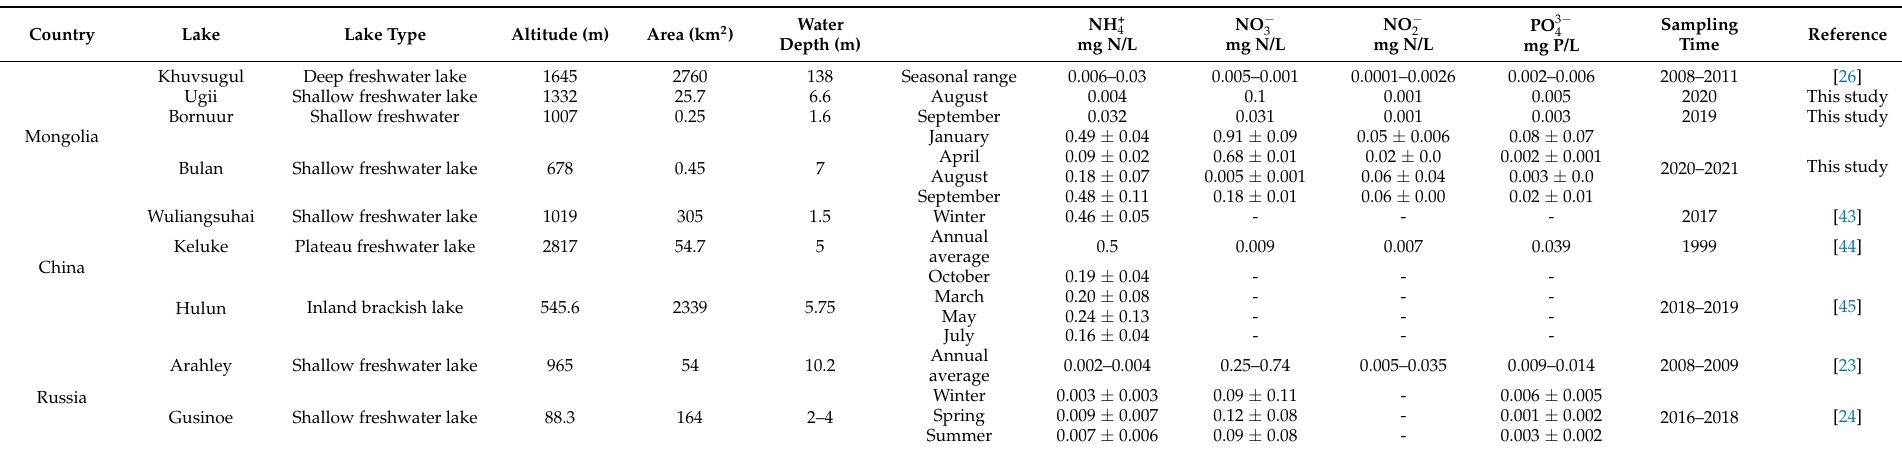
Table 4. Comparison of nutrient concentrations in surface water from Lake Bulan and other